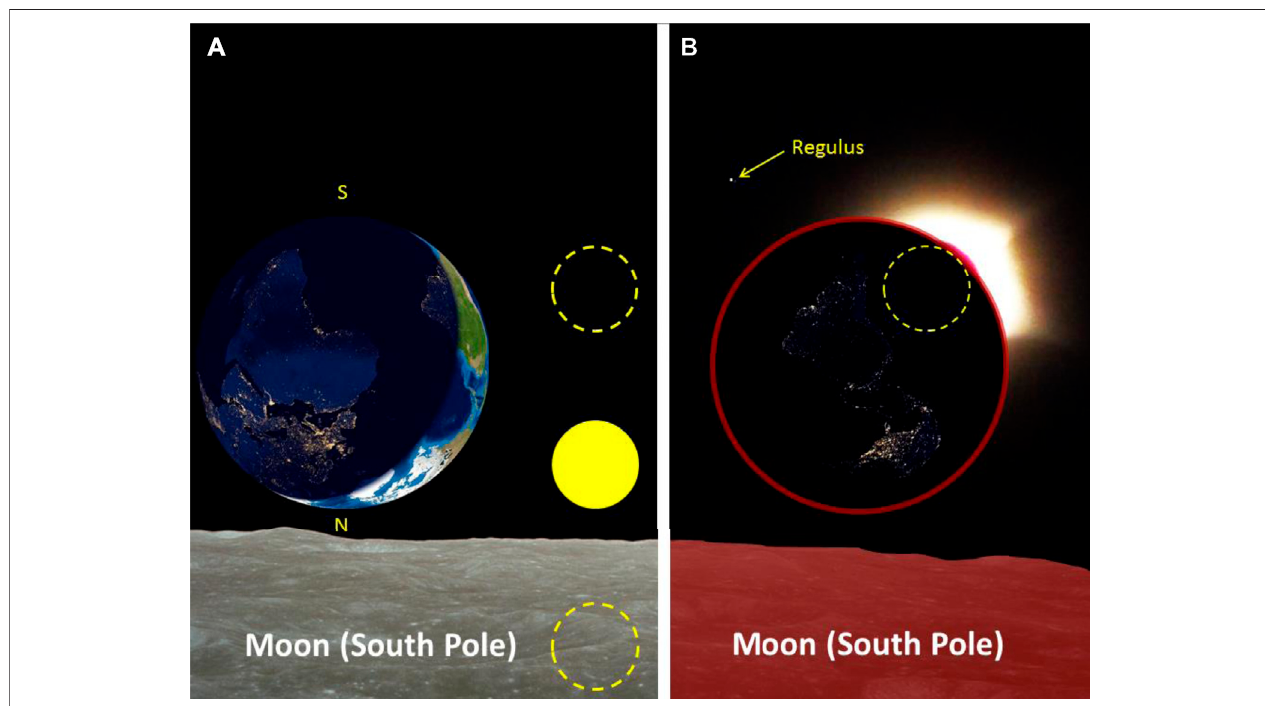
FIGURE 3 | The expected view of the Earth and the Sun from the Moon ’ s South Pole. The picture uses a photo of the lunar surface obtained during the Apollo expedition. Images of the Earth were taken from the Earth and Moon viewer (Walker, 2021). (A) The position ofthe Sun above (or below) the horizon can vary (shown by dashed circles).IftheSunsetsbehindthediskoftheEarth,thenasolareclipseoccursontheMoon – see (B) .DuringasolareclipsetheEarth ’ satmospherewillglowwith redlight,andtheSun ’ scoronawillglowwithwhitelight.StarswillbevisibleneartheSun ’ scorona.Image (B) usesaphotographofthesolarcoronaduringanactual solar eclipse on August 21, 2017, where the star Regulus (constellation Leo) is visible (photo by N. Gorkavyi).